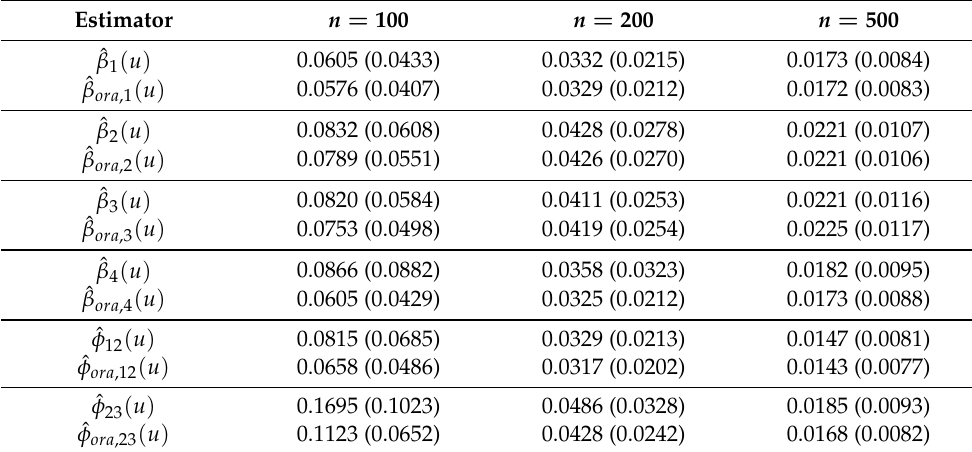
Table 2. MISEs of the functional coefficients estimators for Model